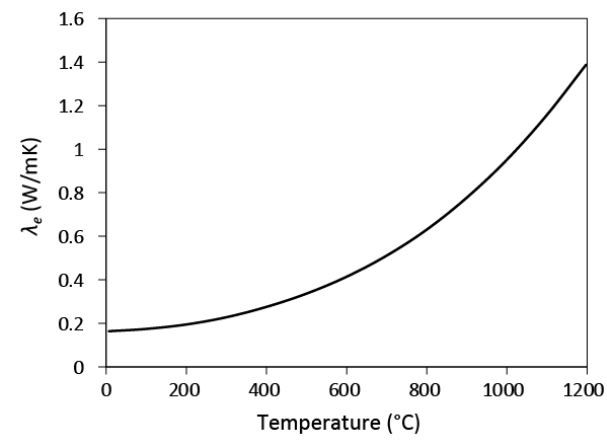
Figure 4. E ff ective thermal conductivity of the growing Figure 4. Effective thermal conductivity of the growing medium.